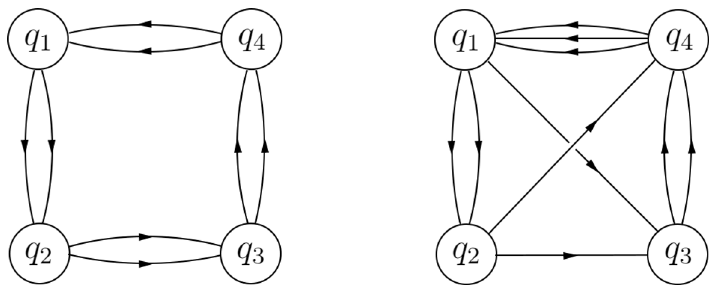
Figure 7 . The quiver diagrams for 5d SU(2) 0 theory (left) and SU(2) π theory